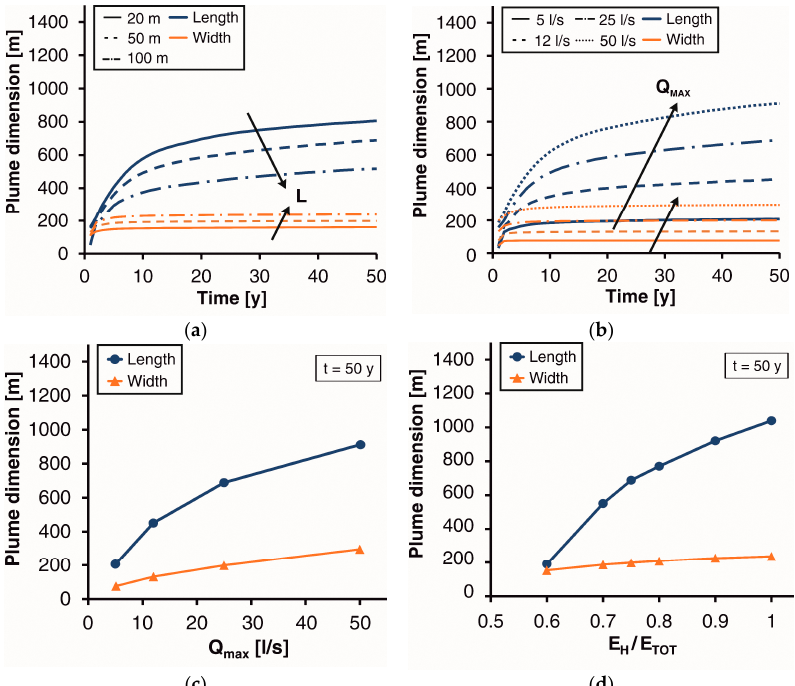
Figure 9. Time evolution of plume dimensions with different values of well spacing L ( a ) and maximum annual injected flow rate Q max ( b ); plume dimensions after 50 years for different values of maximum annual injected flow rate Q max ( c ) and ratio of energy demand for heating over total demand E H / E TOT ( d ); isotherm ∆ T = 1 °C.